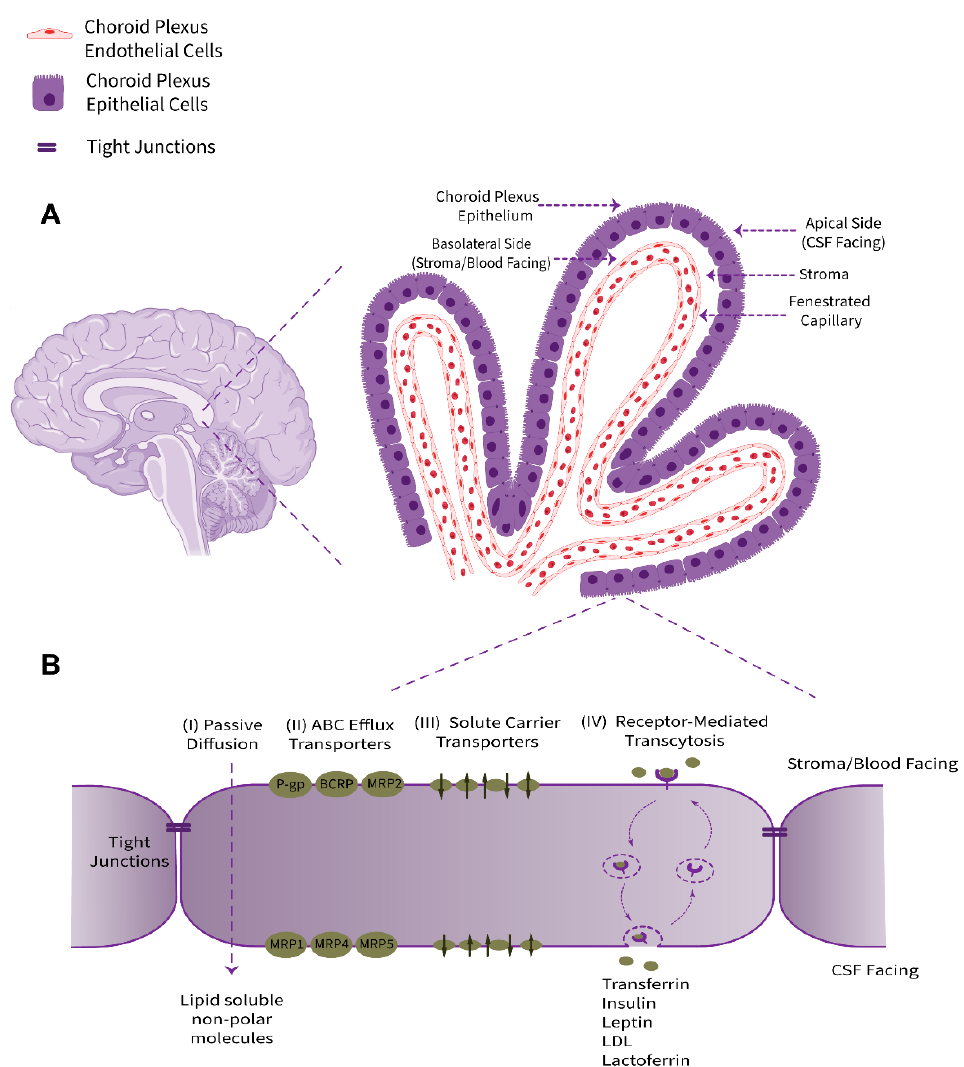
Figure 1. Schematic representation of anatomical location, physiological properties, and pharmacologically related transport systems of the BCSFB. ( A ) The BCSFB structure is comprised of the choroid plexus polarized cuboidal epithelial cells surrounding the highly permeable fenestrated capillaries of stromal core and tight junctional strands uniting adjacent epithelial cells. The innermost capillary (containing red blood cells), with leaky inter-endothelial gap junctions, is alongside the underlying stroma/basement membrane extracellular matrix. The epithelial basolateral surface faces stroma/blood and is in contact with interstitial fluid (ISF). The brush border apical membrane containing microvilli faces the adjacent CSF. ( B ) The main transport-relevant features of the BCSFB in terms of influx and efflux transport systems responsible for supplying nutrients, hormones, and ther- apeutics to the brain/CSF or acting to eliminate metabolites, xenobiotics, and neurotoxic compounds, respectively, are